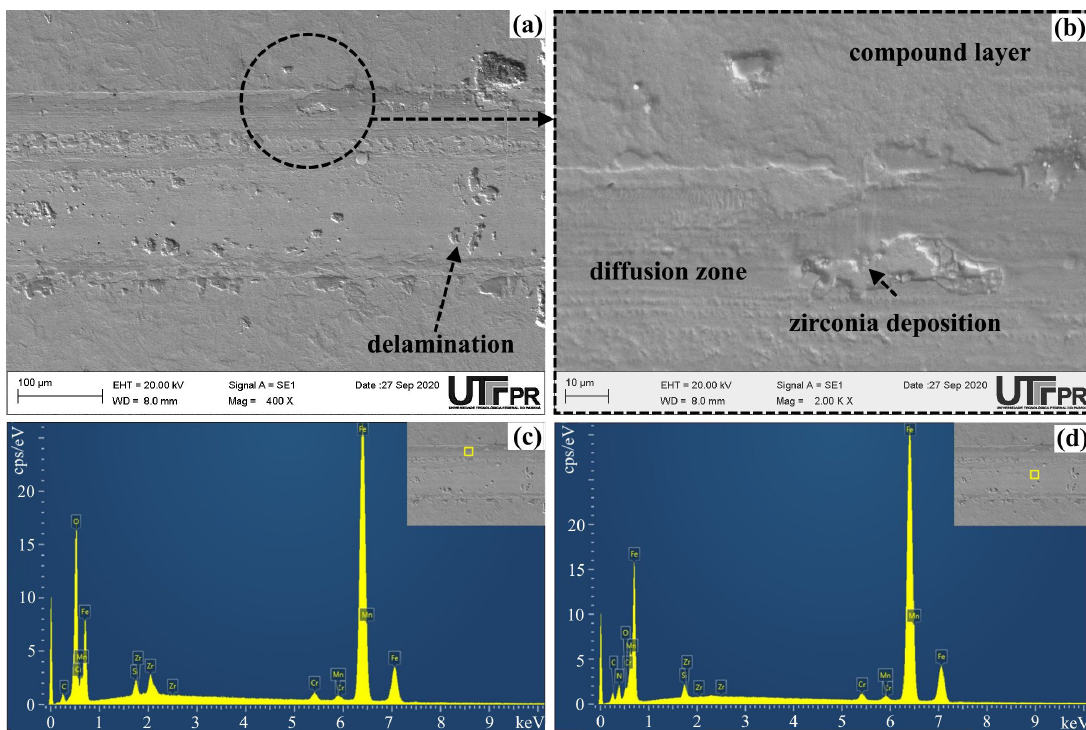
Figure 9. (a, b) SEM images and (c, d) EDS analysis of the wear tracks after reciprocal sliding wear of plasma nitrided samples for 9 h with gas mixture composition of 5 vol.% N . 2